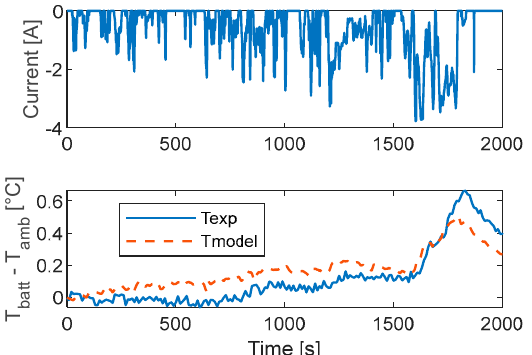
Figure 13. Signal of current ( top ) and comparison of the modeled and experimental temperature ( bottom ) of the battery running the homologation drive cycle WLTC.